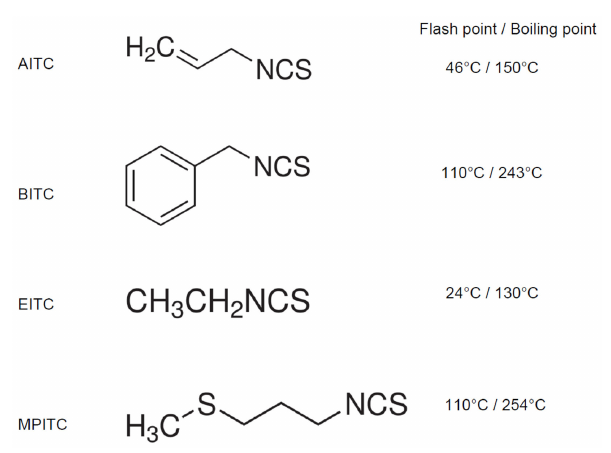
FIGURE 2 | Chemical structure and properties of the four ITC tested in this study. The flash point is the lowest temperature for which the chemical is evaporating to give a combustible concentration of gas and is indicative of the evaporation rate at a given temperature.